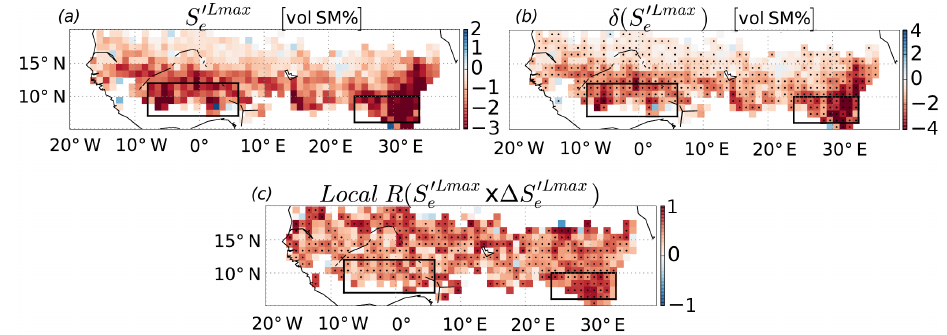
(cid:48) L max e in event locations and (b) its departure from the typical non- (cid:48) L max ◦ box. Significant δ e values with percentiles P e below e in every 1